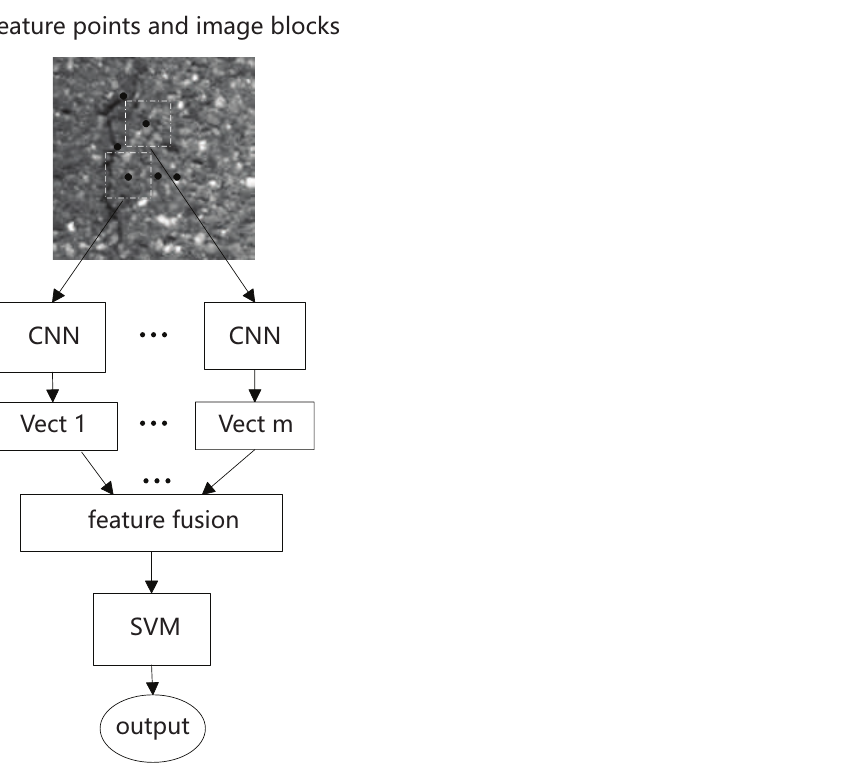
Figure 4. The detailed algorithm flow chart of our